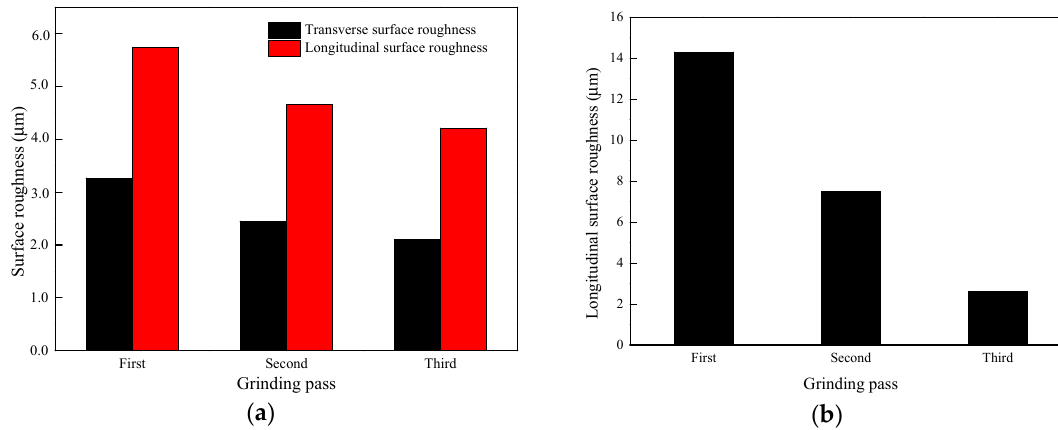
Figure 11. Change in the surface roughness with the number of grinding passes in ( a ) the simulation and ( b ) the experiment.